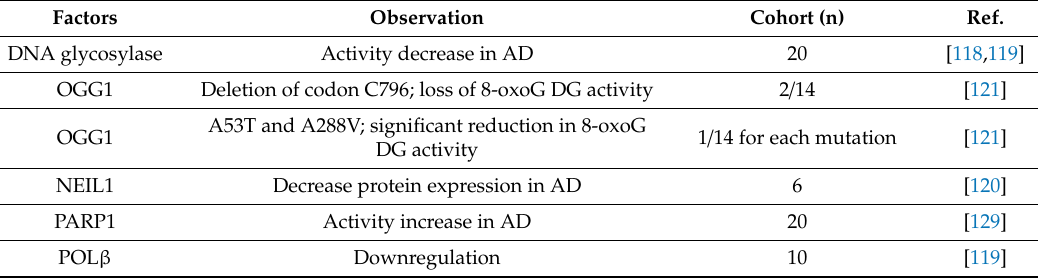
Table 1. Downregulation of BER in Alzheimer’s disease